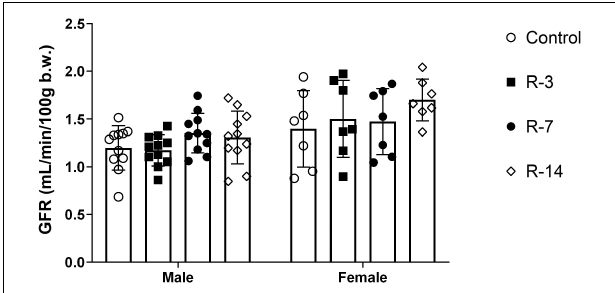
FIGURE 3 | Renal function after release of 24 h total bladder outlet obstruction. The transcutaneous glomerular filtration rate (tGFR) of the mice were constant in both the male and female mice, indicating that renal function was not affected by the 24 h obstruction followed by release. ( n = 11 in each group in the male mice and n = 7 in each group in the female mice). Data are presented as means ± SD.